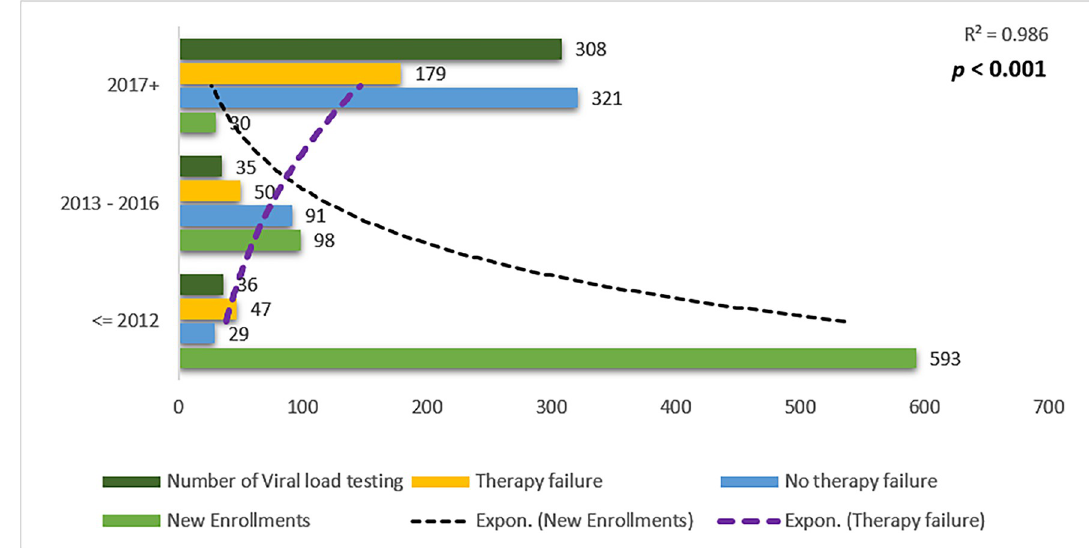
Fig 2. Relationship among viral load tests performed in the clinic and therapy failure detection in National Referral Pediatric Follow-up Clinic, Asmara, Eritrea